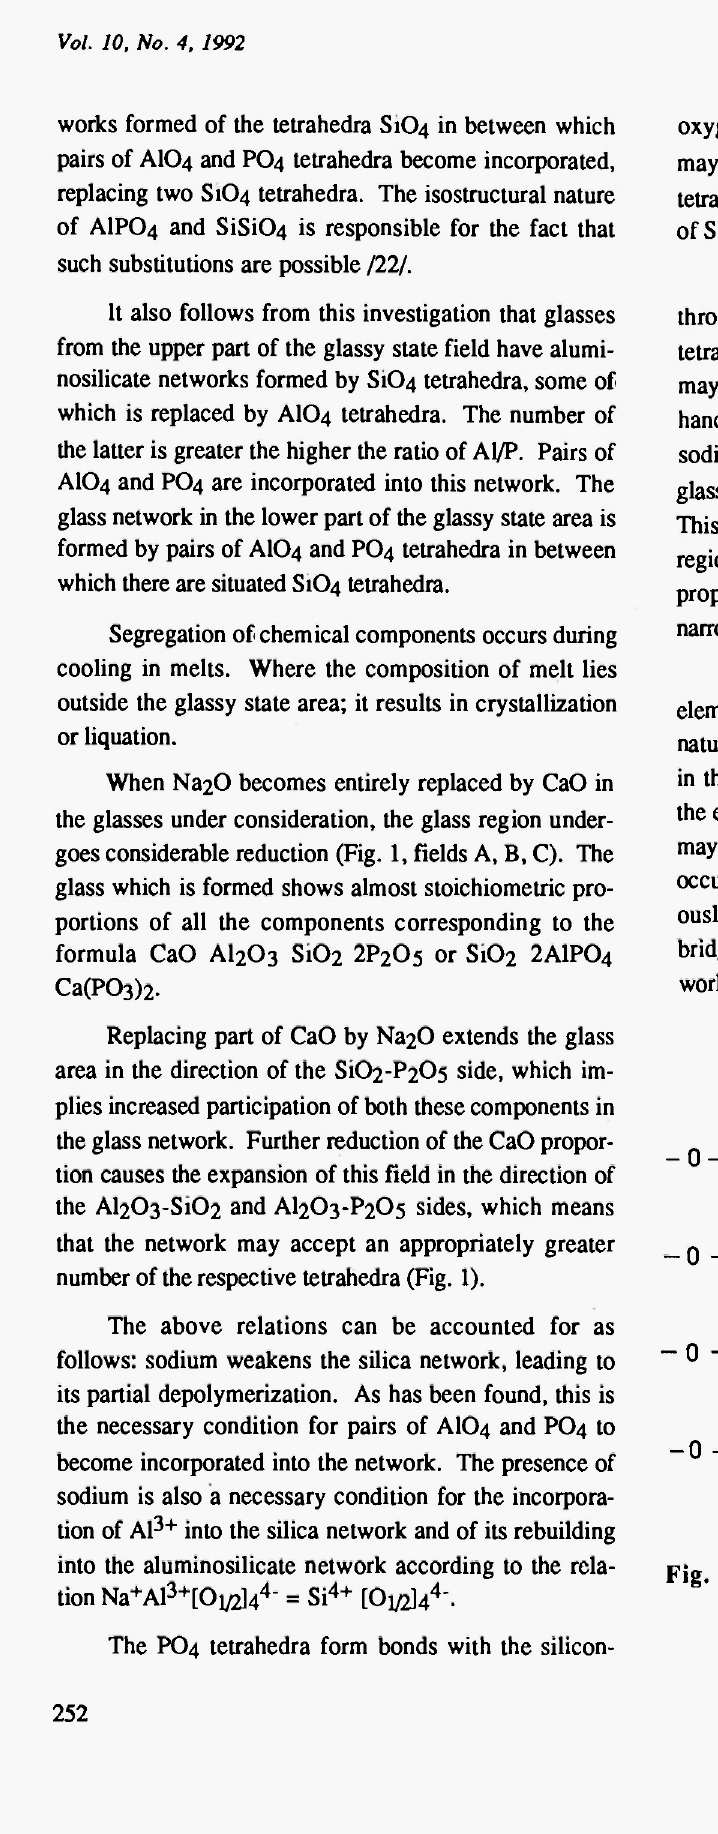
Fig. 2: Function of Al 3+ in the network of Na 2 0- AI2O3-S1O2-P2O5 glasses (non-uniform, continuous